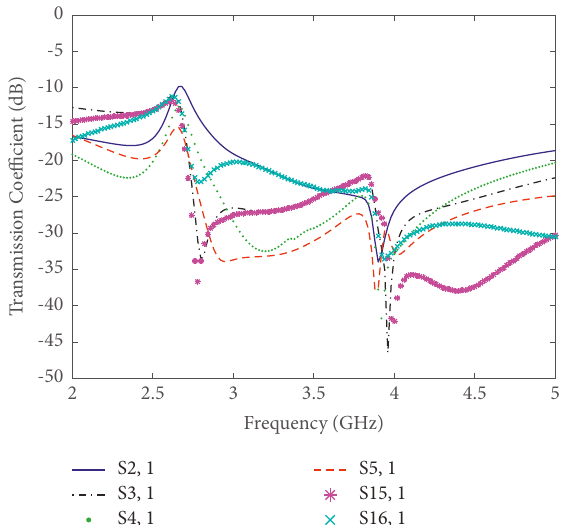
Figure 15: Scattering matrix of 16 PLPA elements around single-tumor phantom: S2, 1-S3, 1-S4, 1-S5, 1-S15, and 1-S16, 1.